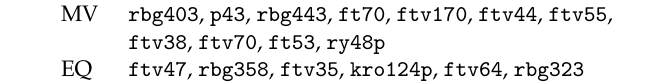
Table 4. Instances for which the Mann Whitney U test supports that there is a significant difference in solution quality between Multiverse and Multistart Ant Colony Optimization in favor of Multiverse (MV) or no difference (EQ). There is no instance so that there is a difference in favor of Multistart.